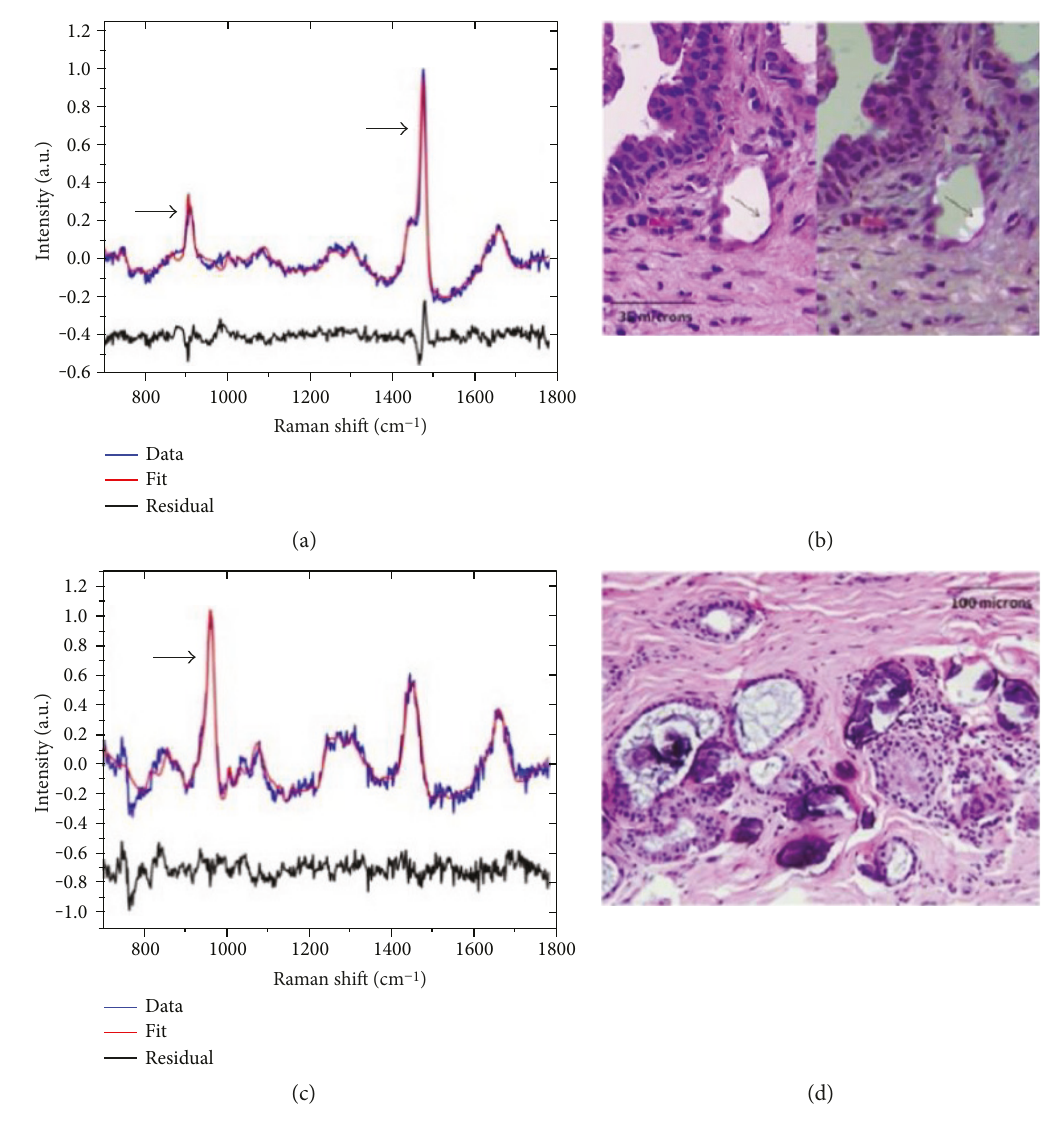
Figure 3: Typical Raman spectra and histopathology of breast lesions ( fi brocystic change) with type I and II microcalci fi cations. The Raman spectrum of the breast lesion with type I microcalci fi cations in (a) shows prominent bands at 912 cm − 1 and 1477cm − 1 (arrows) characteristic of calcium oxalate; the calcium oxalate crystals comprising the type I microcalci fi cations (b) do not bind H&E (left panel) and appear as colorless crystals (arrows) that are birefringent when viewed under polarized light (right panel). In contrast, the Raman spectrum of the breast lesion with type II microcalci fi cations in (c) shows a prominent band at 960cm − 1 (arrow) characteristic of calcium hydroxyapatite; the calcium hydroxyapatite rich type II microcalci fi cations appear as basophilic concretions on the H&E stain (d) and are nonbirefringent [59,